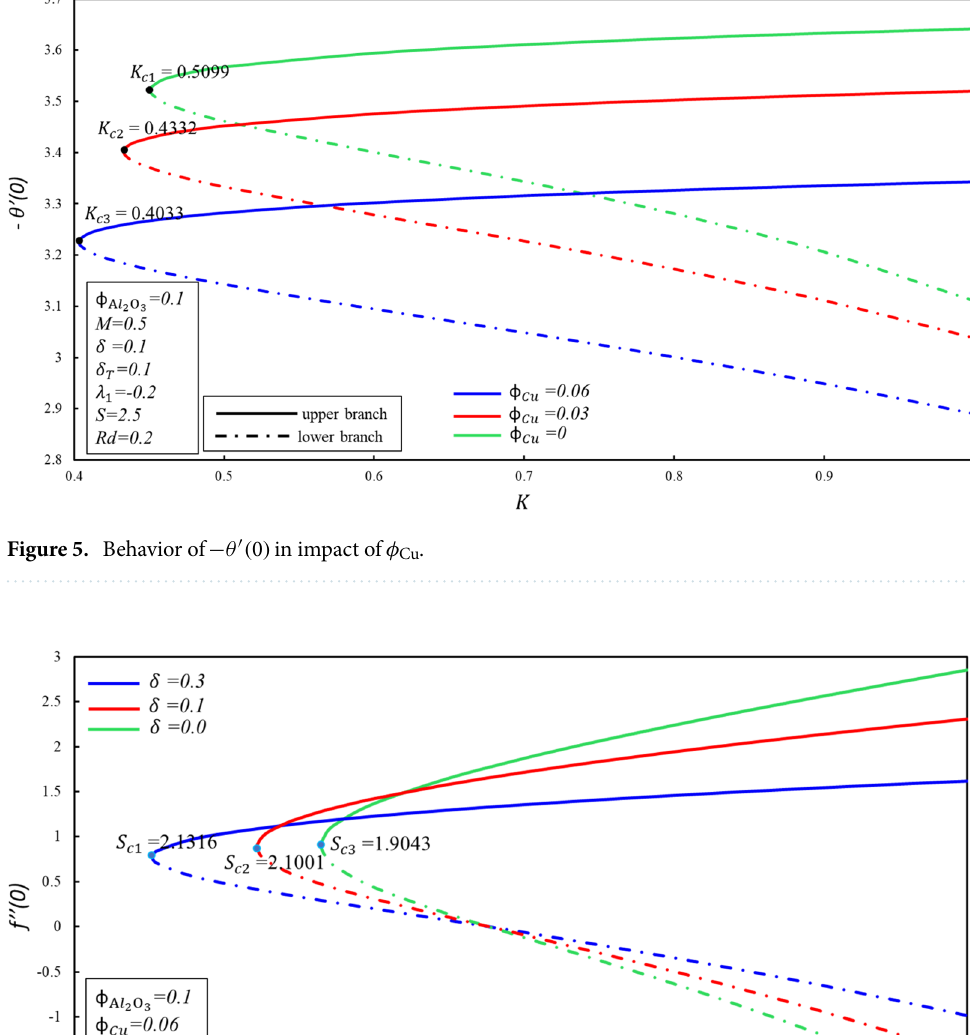
Figure 6. Behavior of f ′′ ( 0 ) in impact of δ